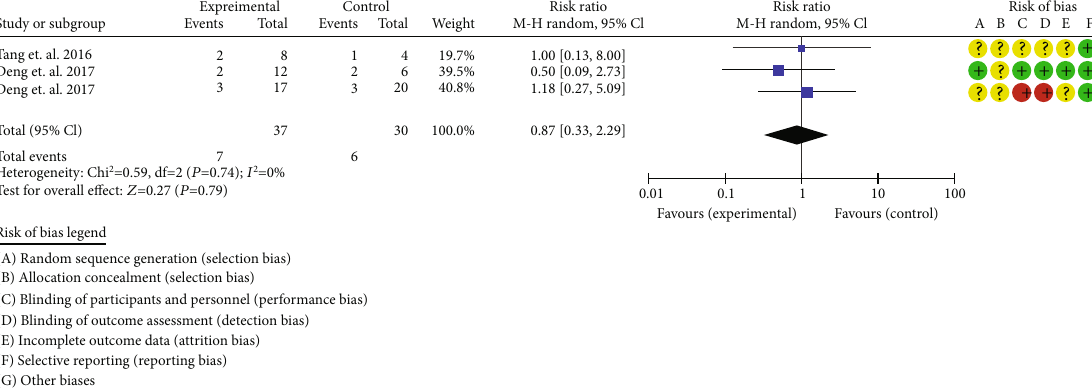
Figure 7: Adverse events of SLE (CI: con fi dence interval).